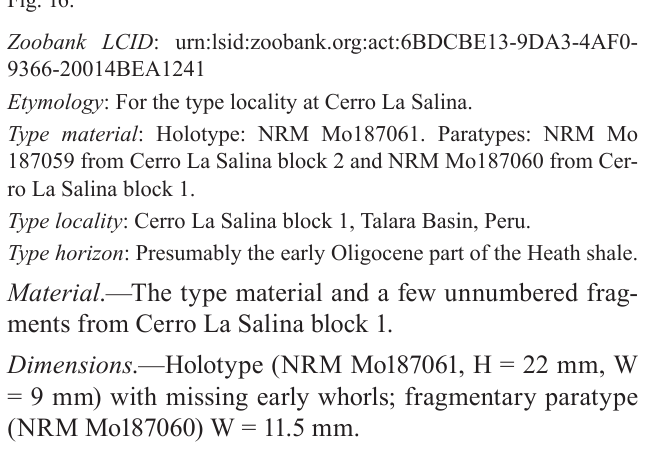
Material .—One specimen (NRM Mo187064, H = 7 mm) from the Belén seep site, upper Oligocene, Talara Basin,